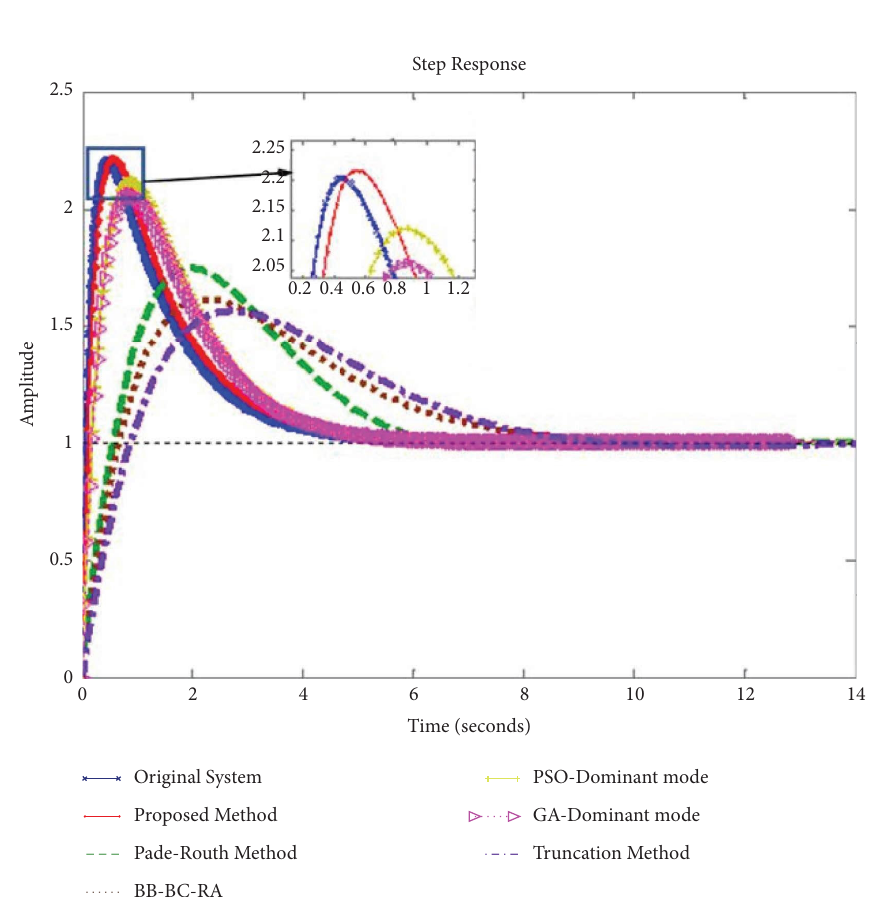
Figure 5: Comparison of the step responses of the original system to other comparable Figure 7 explains the relative integral square error (RISE) values of original system with its diferent reduced models.